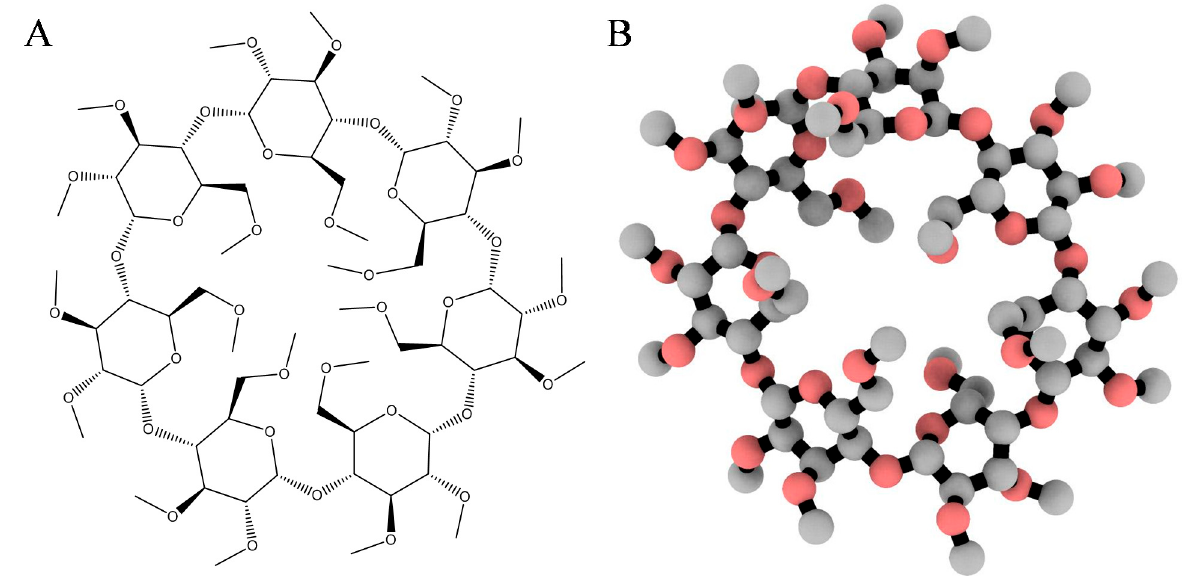
Figure 8. Two- ( A ) and three-dimensional ( B ) representation of the heptakis-(2,3,6-tri- O - methyl)- β -cyclodextrin (TRIMEB) structure. The 3D model is rendered as ball-and-stick and coloured according to atom type without hydrogens to enhance